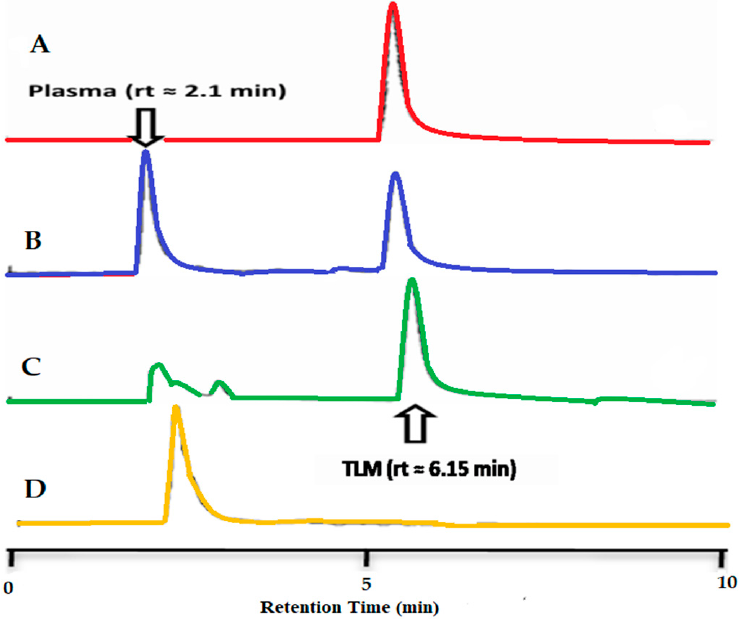
Figure 10. HPLC chromatograms of ( A ) TLM, ( B ) TLM in blank plasma, ( C ) plasma samples taken after injection of TLM-FDTs, and ( D ) blank plasma. Table 6. The plasma pharmacokinetic characteristics of TLM-FDTs and Tolectin ® tablets in rats after oral delivery.